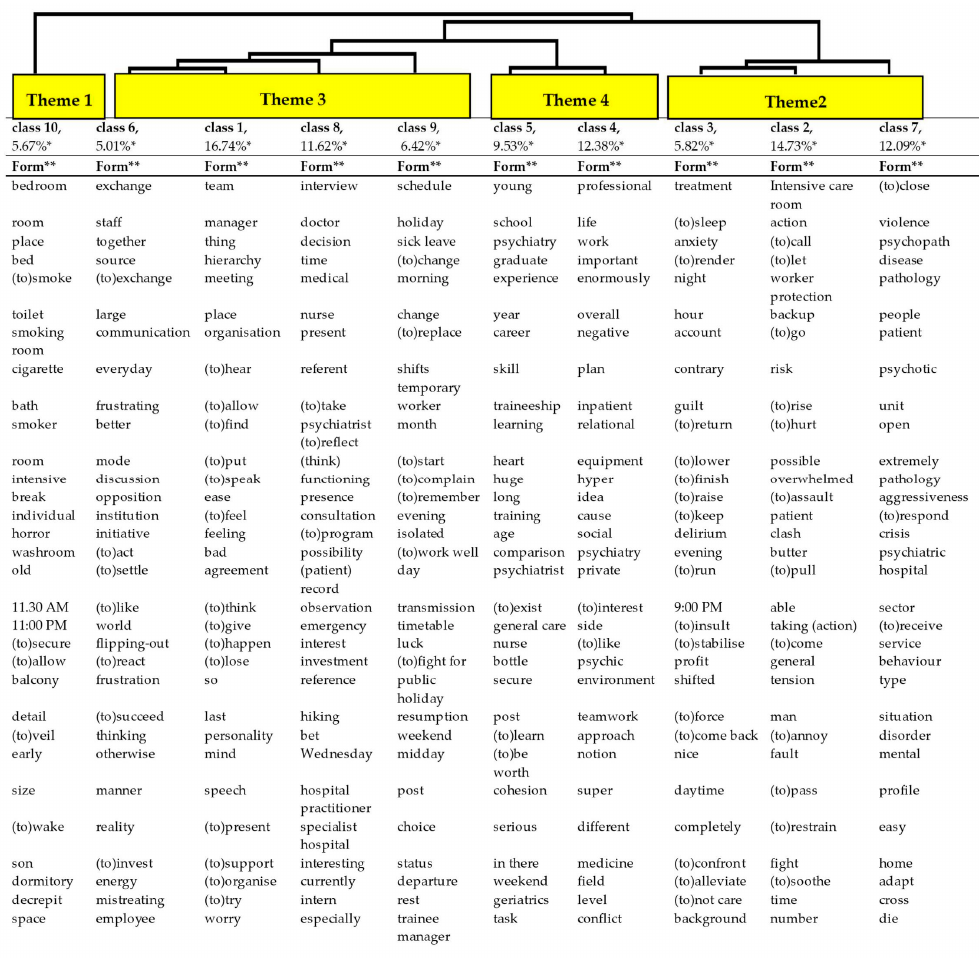
Table 3. Hierarchical structure and words associated with classes.